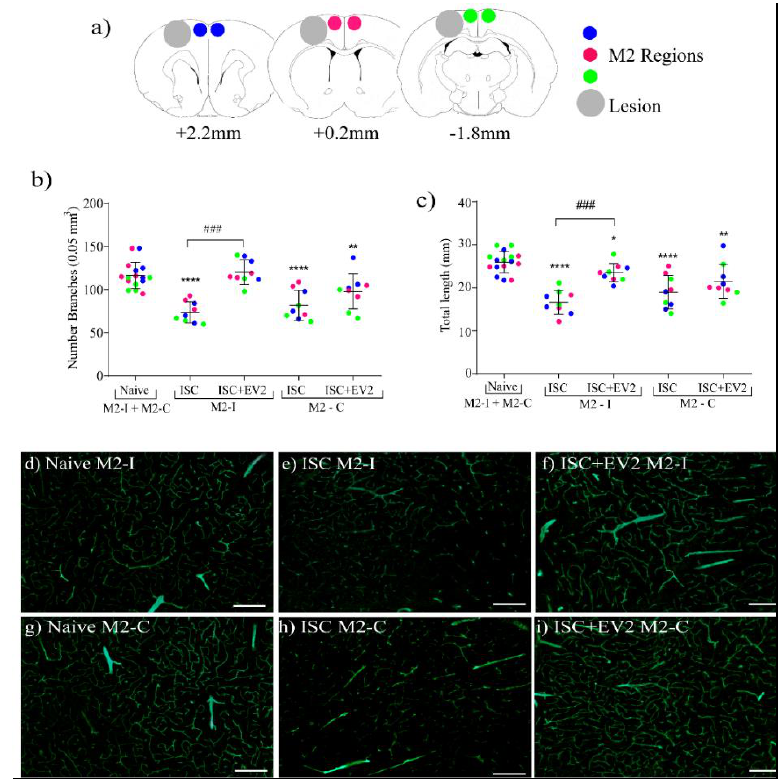
Figure 9. Brain blood vessel parameters measured on day 42 after treatment with EV2 in supple- mentary motor cortex region (M2); volume of piece: 0.05 mm 3 . ( a ) Scheme on brain regions analyzed: ipsi- peri-infarct region and its contralateral equivalent (positions +2.20, +0.2, and −1.88 mm to Bregma); ( b ) number of vessel branches in M2-ipsi- (M2-I) and M2-contralateral (M2-C) regions; ( c ) total vessel lengths in M2-I and M2-C regions; ( d – i ) representative images of blood vessel in M2 region located at position +0.20 mm to Bregma: ( d ) naive M2-I; ( e ) ISC M2-I; ( f ) ISC+EV2 M2-I; ( g ) naive M2-C; ( h ) ISC M2-C; ( i ) ISC+EV2 M2-C. Statistical analysis using the unpaired t test. Data are reported as mean ± SD. * p < 0.05, ** p < 0.01, **** p < 0.0001, compared to naive group; ### p < 0.001 compared to ISC group (n = 3). Scale bars = 20 µ